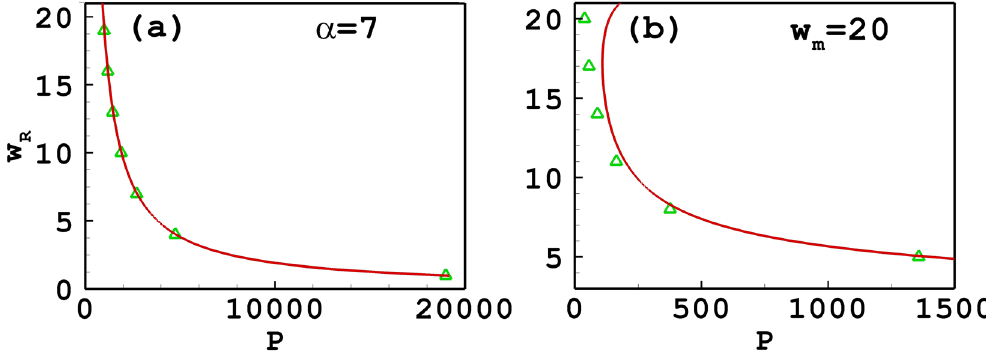
Figure 5. The soliton width versus the power of quadrupole-mode solitons. ( a ) The degree of nonlocality is fixed at α = 7; ( b ) the width of the response function is fixed at w m = 20. The solid line and the triangles denote, respectively, approximate solutions and the numerical